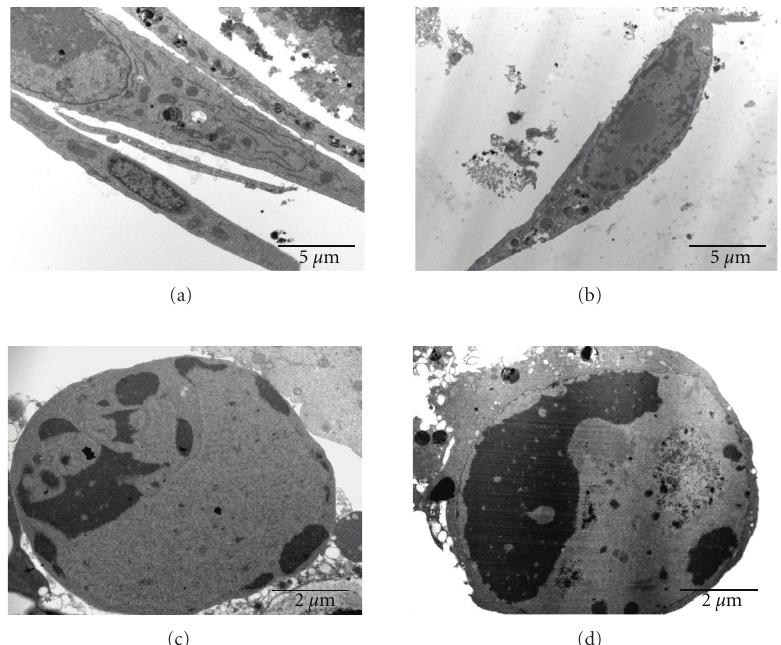
Figure 5: Inhibition of Cdk5 expression does not protect cells from death. COS-7 cells treated with CPT at 48hours with or without transfection of Cdk5 dsRNA were fixed for electron microscopy. (a) and (b) Untreated cells transfected with Cdk5-1 (a) or Cdk5-2 (b) are elongated and display large nuclei, comparable to controls that were not transfected (see Figure 3(b)(A); otherwise not illustrated). (c) and (d) CPT-exposed dying cells in control (c) and transfected with Cdk5-1 dsRNA (d) were apoptotic. An apoptotic cell has a condensed nucleus and cytoplasm and increased electron density while the chromatin is coalesced and electron-dense. Cells killed by CPT are apoptotic regardless of the concentration of